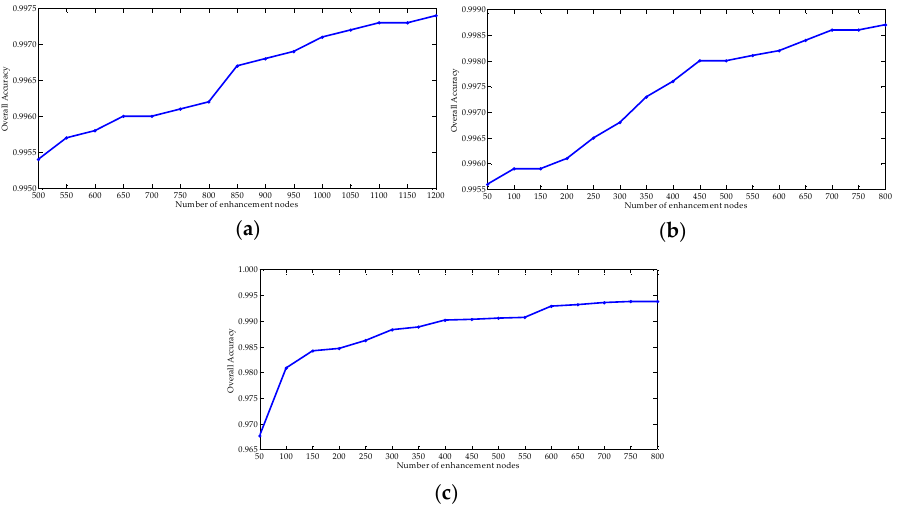
Figure 7. The relationship of the number of enchancement nodes ( E ) and OA in the three datasets.